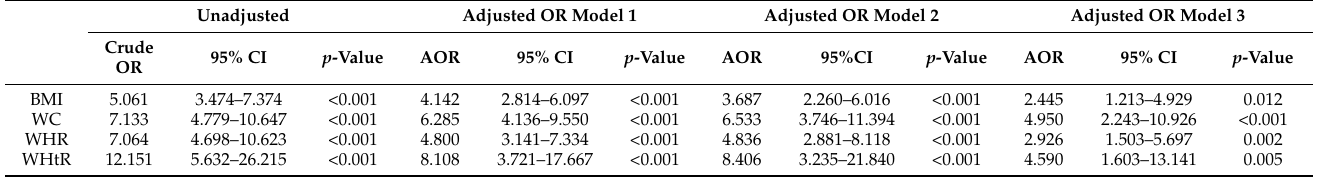
Table 3. The risk for diabetes mellitus among South African males aged 20 years and older by anthropometric indices: SANHANES-1.